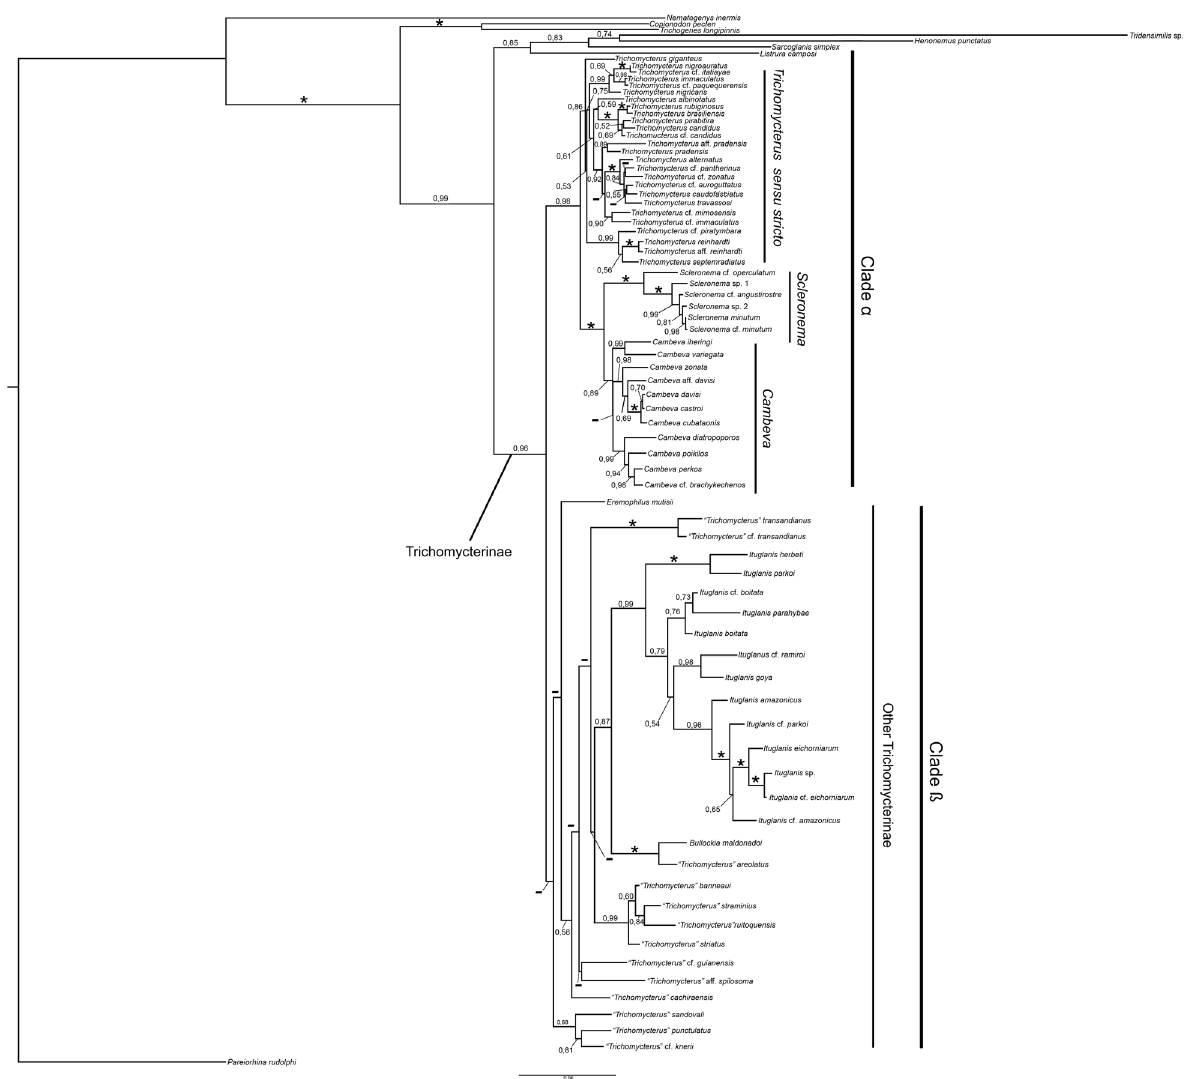
Figure 2. Phylogenetic positioning of Cambeva among the Trichomycteridae, inferred by Maximum Likehood from the analysis of molecular data, total of 4380 bp comprising segments of nuclear genes for GLYT, MYH6, RAG2 and SH3PX3 and the mitochondri- al genes COI and CYTB. Numbers on each node are bootstrap percentages of the Maximum Likelihood analysis; asterisks indicate maximum support value and hyphen values under